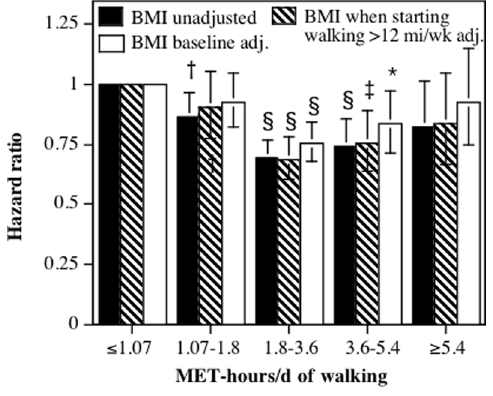
Figure 2. Relative risk (hazard ratio) for all-cause mortality vs. walking energy expenditure adjusted for sex, age (age plus age 2 ), race, education, smoking status (current and prior history), prior history of heart attack and cancer, daily intakes of alcohol, meat and fruit, aspirin use. Brackets designate 95% confidence intervals. Significance levels for the risk reduction relative not achieving the minimum recommended exercise level (i.e., , 1.07 MET-hours/d) are coded: * P , 0.05, { P , 0.01, ` P , 0.001, and